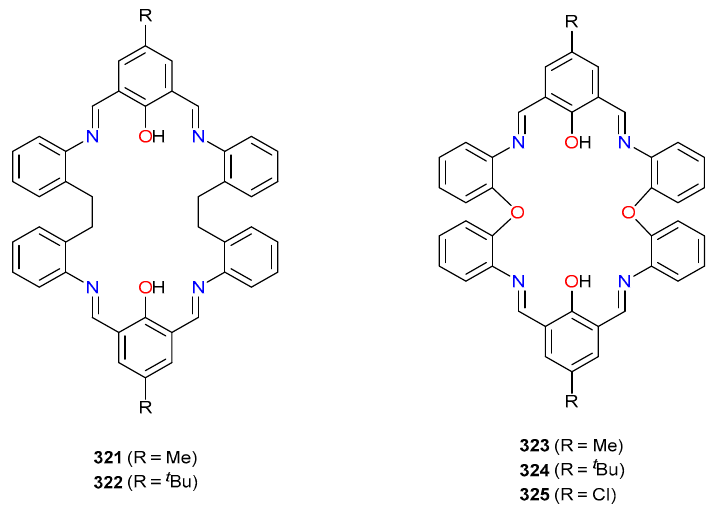
Figure 49. Ethylene- and oxo-bridged [2 + 2] macrocyclic Schiff-base ligands [109,140].